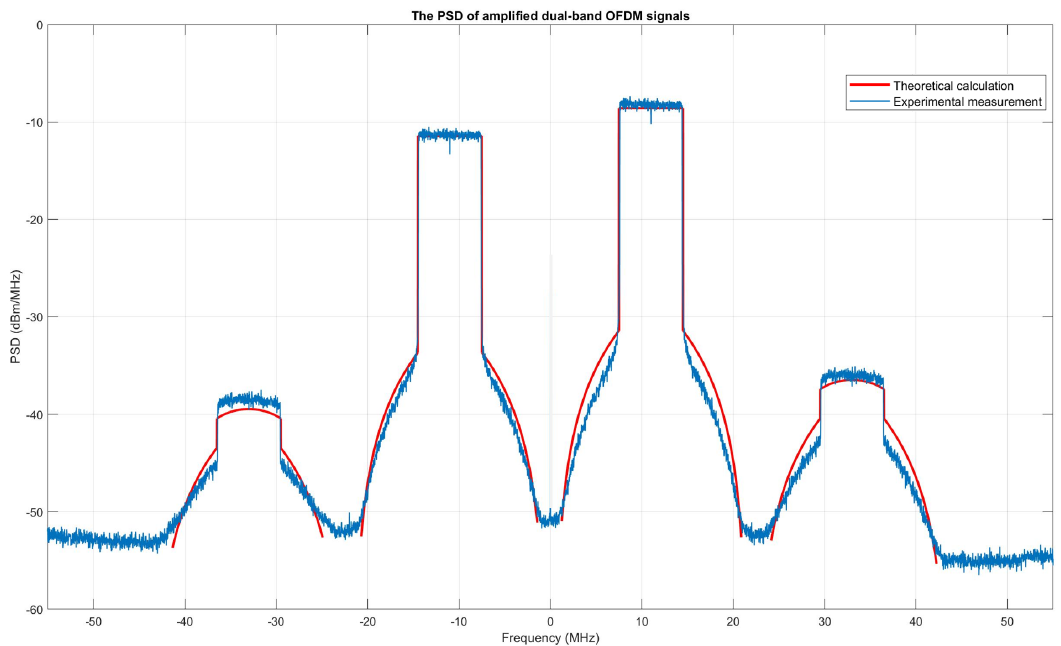
Figure 4. The red line is the theoretically predicted PSD, and the blue line is the experimental